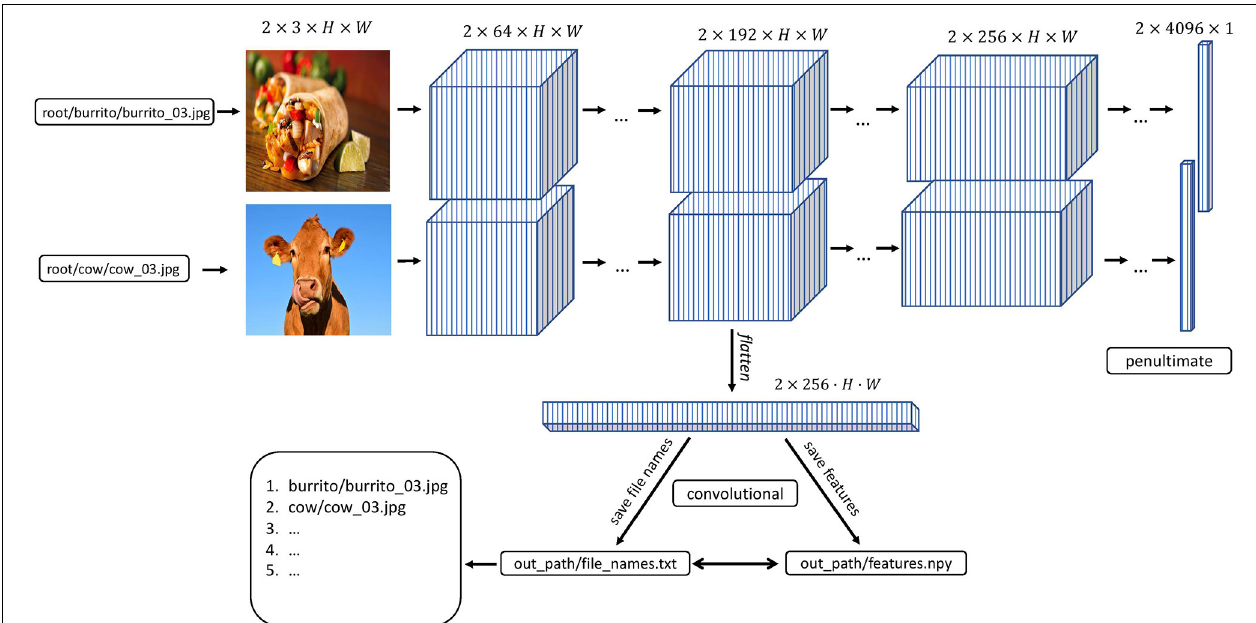
FIGURE 1 | THINGSvision feature extraction pipeline for an example convolutional neural network architecture. Images and activations in early layers of the model are represented as four-dimensional arrays. The first dimension represents the batch size, i.e., the number of images in a subsample of the data. For simplicity, in this example this number is set to two. The second dimension refers to the channel-dimension, and the last two dimensions represent the height and width of an image or feature map, respectively.